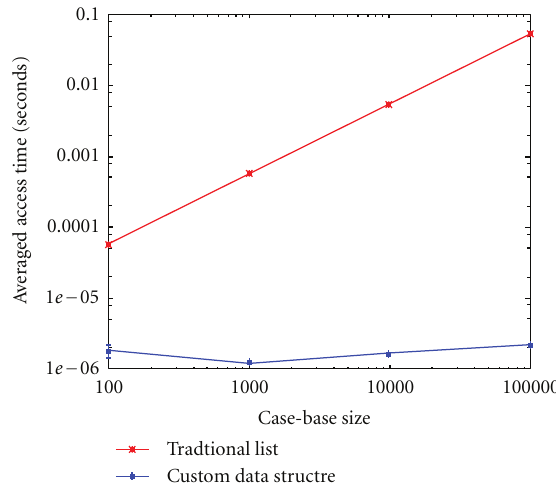
Figure 7: Average access time for the traditional storage approach versus a custom